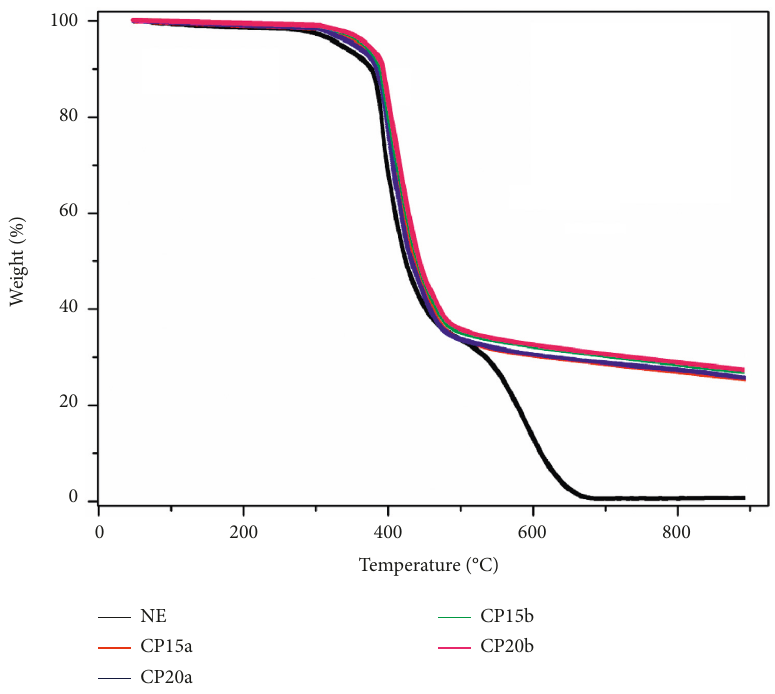
Figure 4: Thermogravimetric analysis pebble filler epoxy